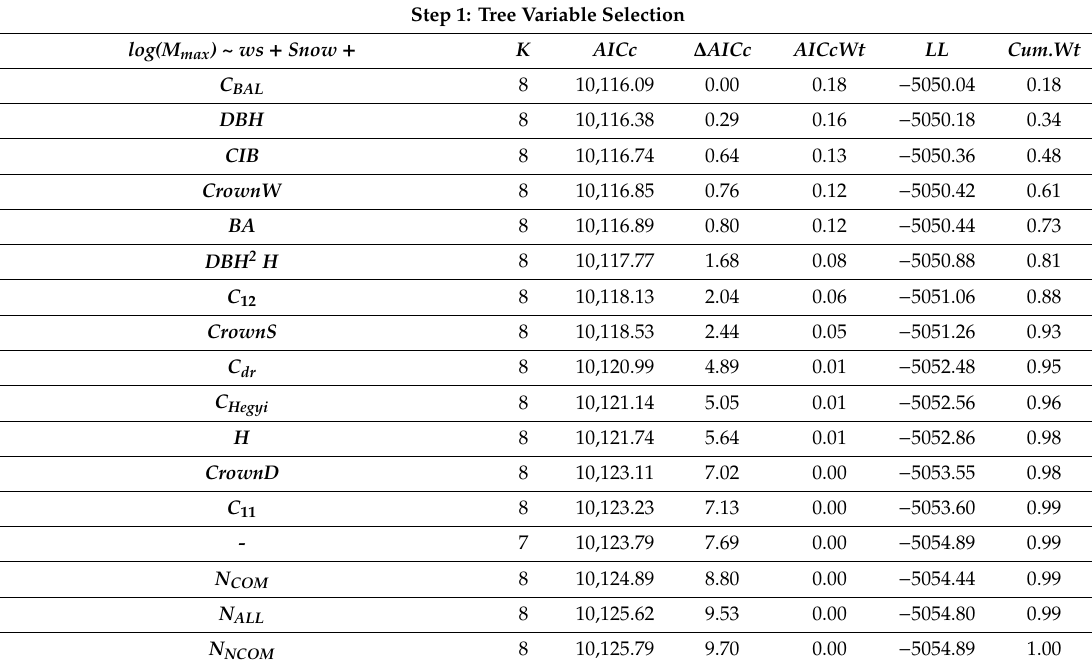
Table 2. Snow thickness model